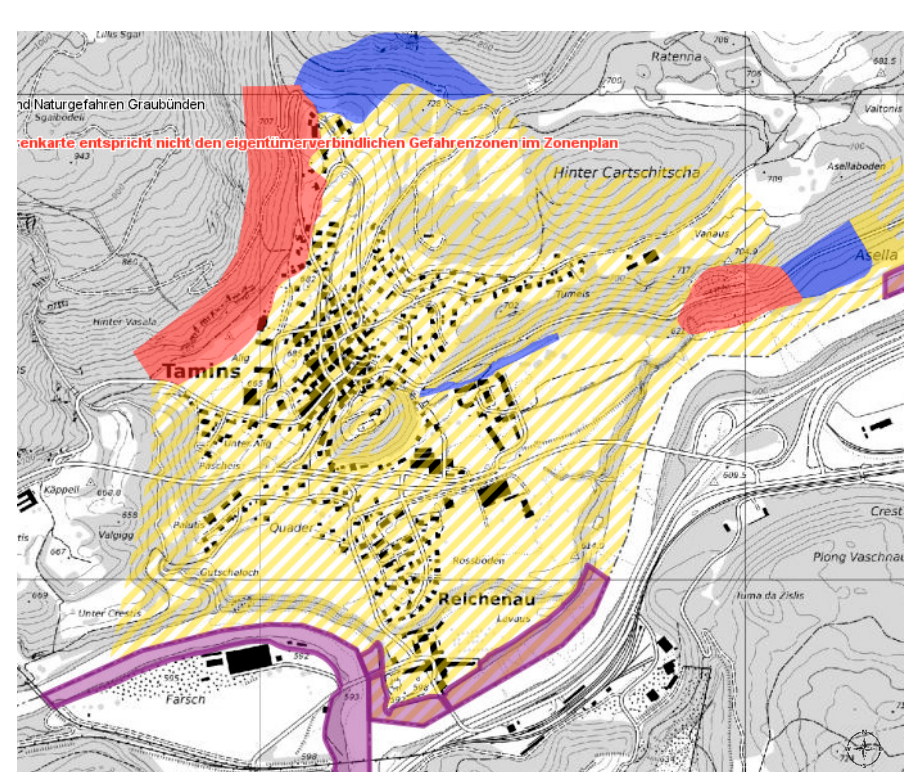
Figure 4. Natural hazard risk map of Tamins: rock fall risk zone (Latitude: 46.828093 | Longitude: 9.406315; © Canton of Grisons).